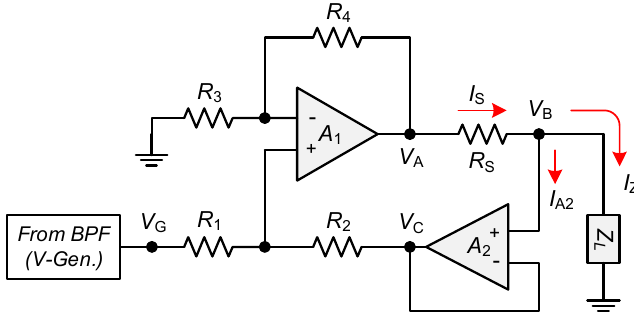
Figure 3. Howland current source with buffered feedback.